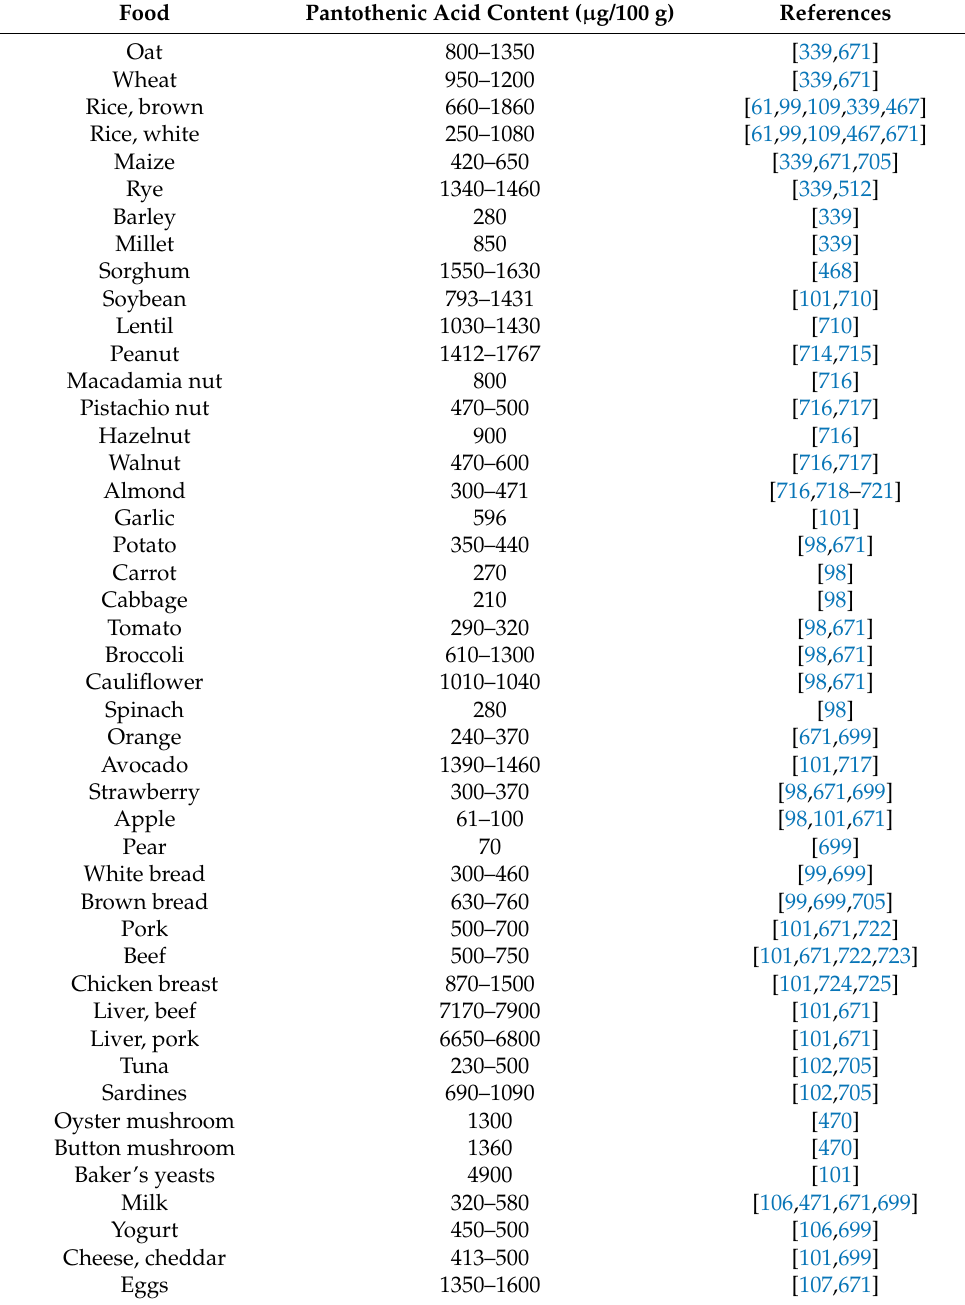
Table 10. Pantothenic acid contents in selected